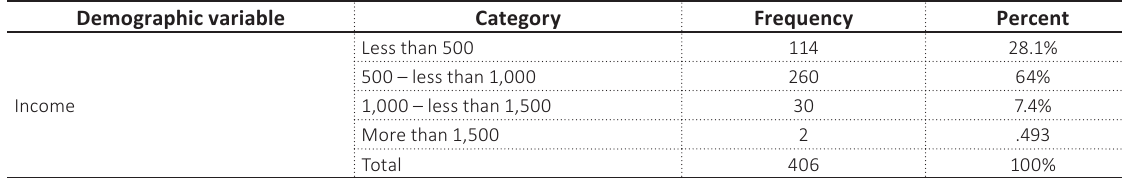
Table 7. Distribution of respondents’ income